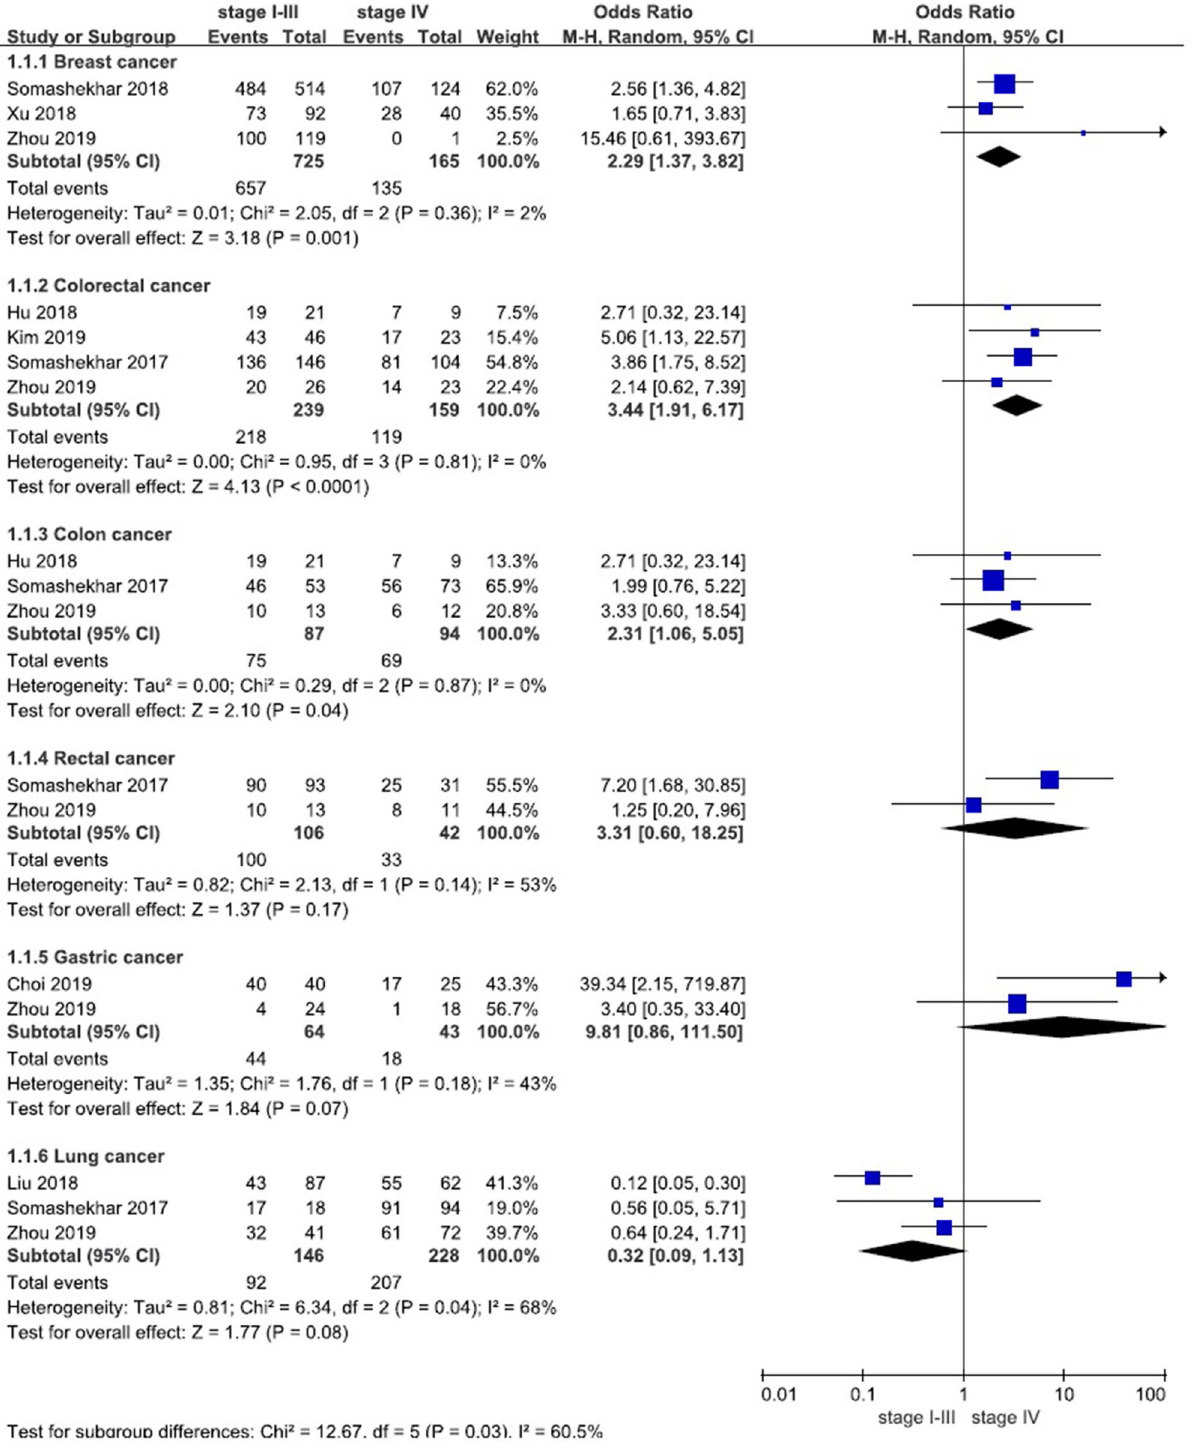
Figure 4. Forest plot of consistency between WFO (‘Recommended’ or ‘For consideration’) and MDT for patients